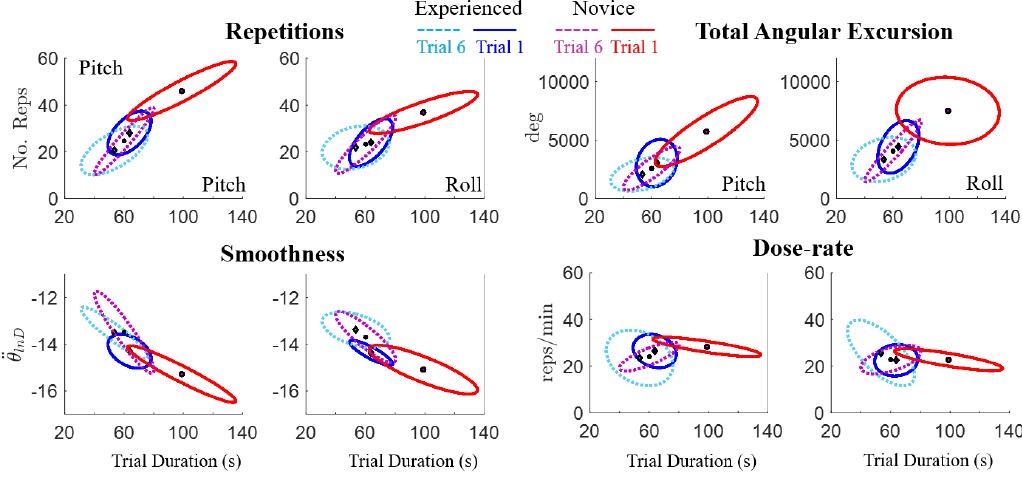
Figure 9. Sample-distribution ellipses (75% confidence intervals) for novice and experienced participants from Figure 8 are overlaid to demonstrate the convergence of the participant groups’ motor performance by Trial 6, based on the overlapping sample-distribution